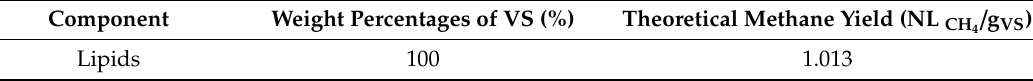
Table A4. Calculation of theoretical methane productivity of